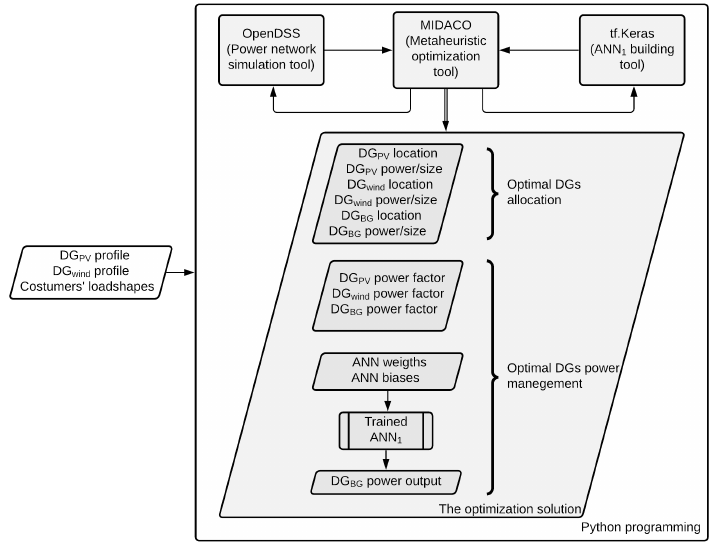
Figure 1. The framework used for Opt 1 optimization scenarios.